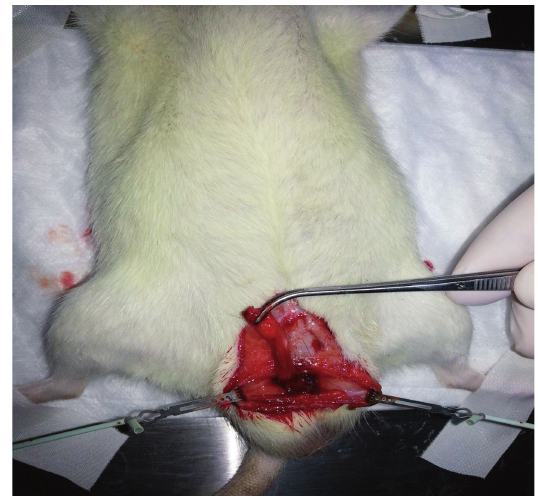
Figure 2 - Dissected rat